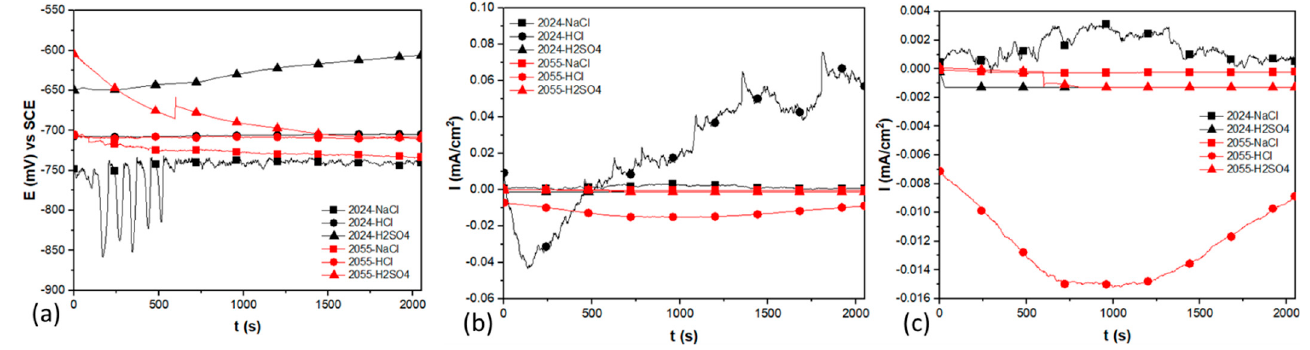
Figure 8. Electrochemical potential noise ( a ) and electrochemical current noise ( b ) noise-time series for AA2024 and 2055 alloys in T8 heat treatment condition, exposed to 3.5 wt. % NaCl, 1 wt. % HCl, and 1 wt. % H 2 SO 4 solutions. ( c ) Windowing of electrochemical current noise (ECN) from 0.004 to − 0.016 mA.